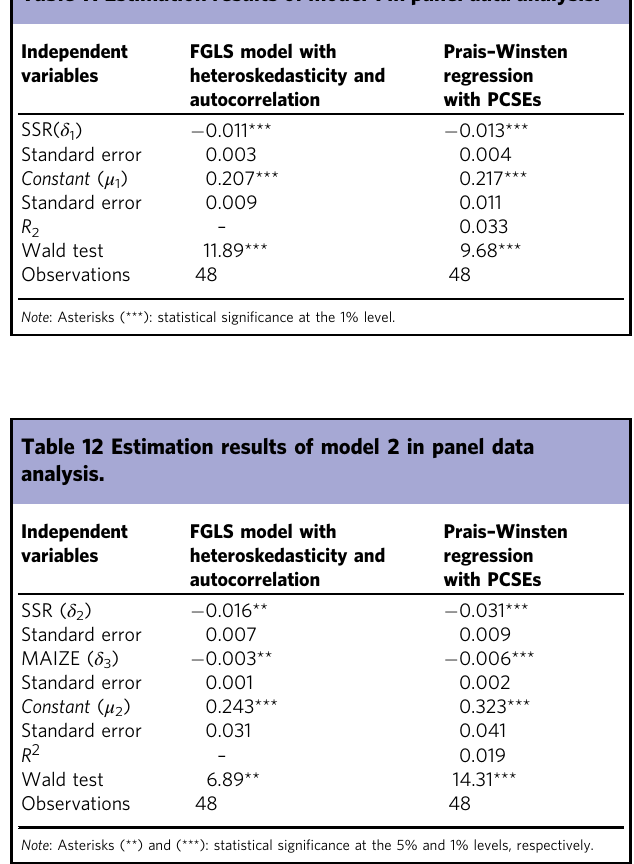
Table 11 Estimation results of model 1 in panel data